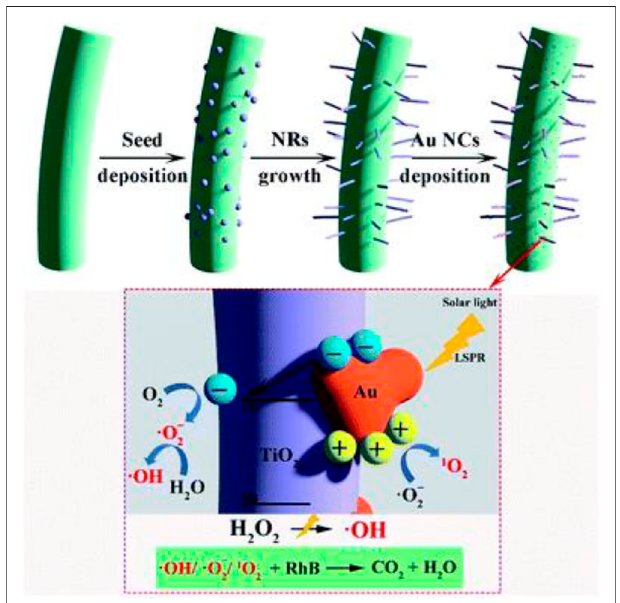
FIGURE 11 | Schematic representation of seed-mediated TiO2 NR synthesis, Au NCs deposition, and suggested photocatalytic process for